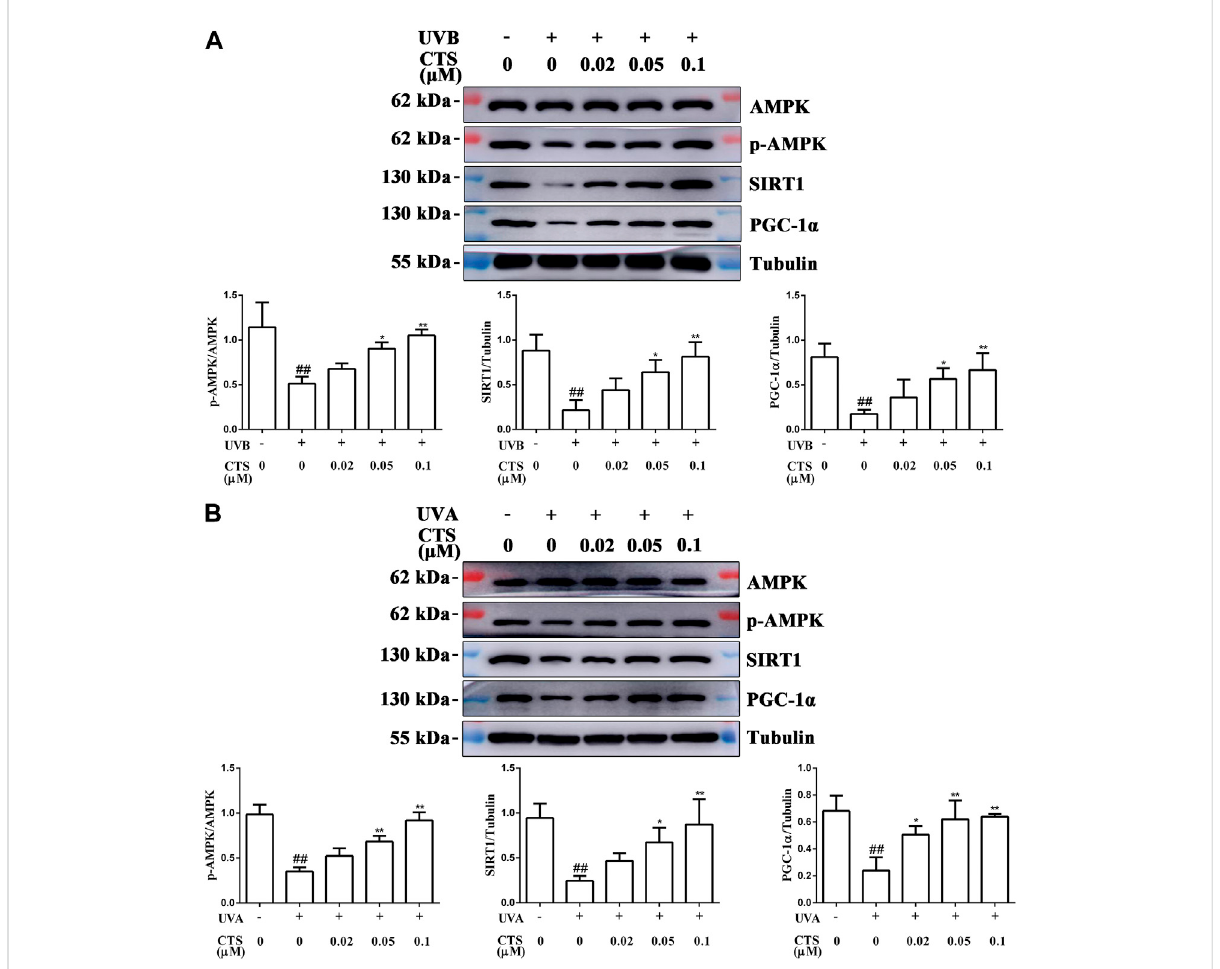
FIGURE 5 CTS promotes mitochondrial biosynthesis via the AMPK/SIRT1/PGC-1 α signaling pathway. HaCaT cells and HFF-1 cells were treated with CTS (0, 0.02, 0.05, 0.1 μ M) for 4 h and irradiated with UVB (200 mJ/cm 2 ) or UVA (15 J/cm 2 ), respectively. Then, the cells were supplemented with the corresponding doses of CTS and incubated for another 0.5 h before analysis. (A) Protein levels of p-AMPK, SIRT1 and PGC-1 α in HaCaT cells as measured by western blot. The plots beside the blots show the relative expression levels of p-AMPK, SIRT1 and PGC-1 α as determined by grayscale analysis of the bands in the blots. (B) Protein levels of p-AMPK, SIRT1 and PGC-1 α in HFF-1 cells as measured by western blot. The plots beside the blots show the relative expression levels of p-AMPK, SIRT1 and PGC-1 α as determined by grayscale analysis of the bands in the blots. All dataaremean ±SDfromthree independent experiments, “ ## ” indicates signi fi cantly differentfrom thecontrol(noirradiation andCTS treatment)at the p < 0.01 level, whereas “ * ” and “ ** ” indicate signi fi cantly different from the UV-irradiated cells without CTS pretreatment at the p < 0.05 and p < 0.01 levels,